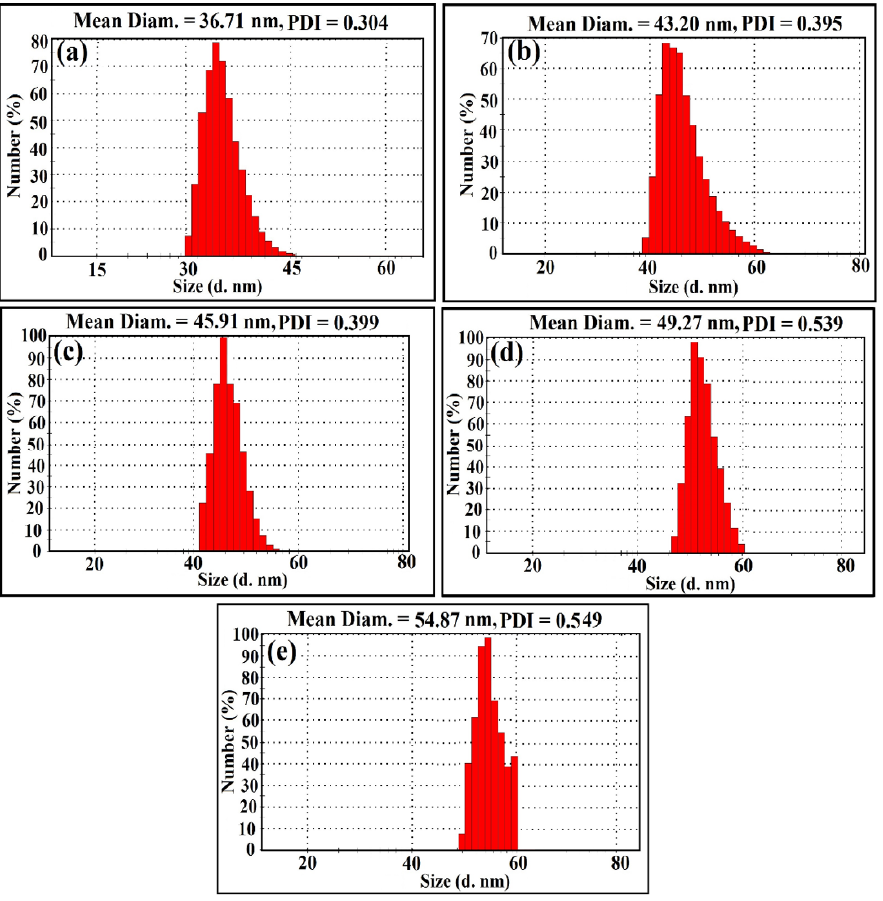
Figure 6. Particle size distribution and PDI determination of ZnCe x Fe 2 − x O 4 by DLS when ( a ) X = 0, ( b ) X = 0.02, ( c ) X = 0.04, ( d ) X = 0.06, and ( e ) X = 0.08 at pH 7 (cultural media pH).